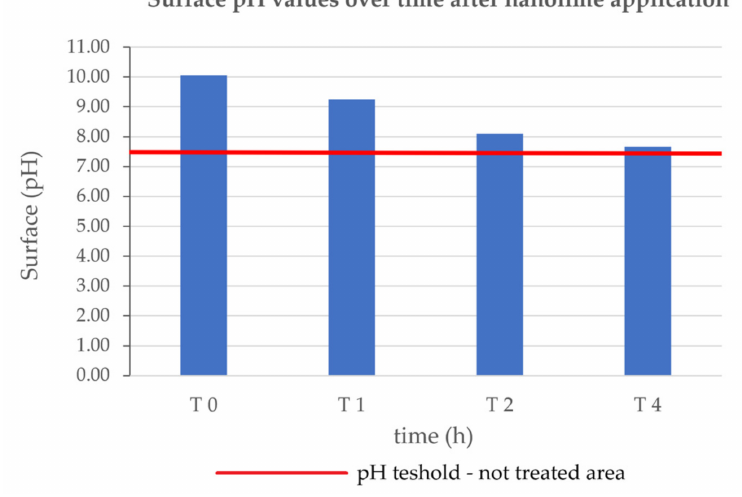
Figure 7. pH values over time (in hours) on paintings in